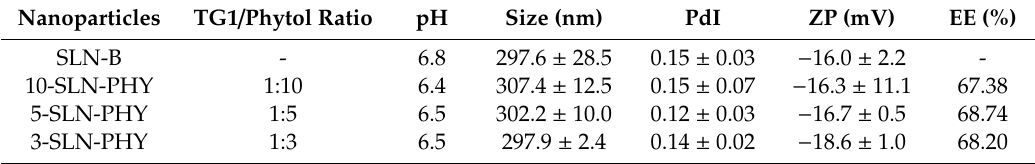
Table 1. Physicochemical properties of di ff erent solid lipid nanoparticles (SLN) formulations.